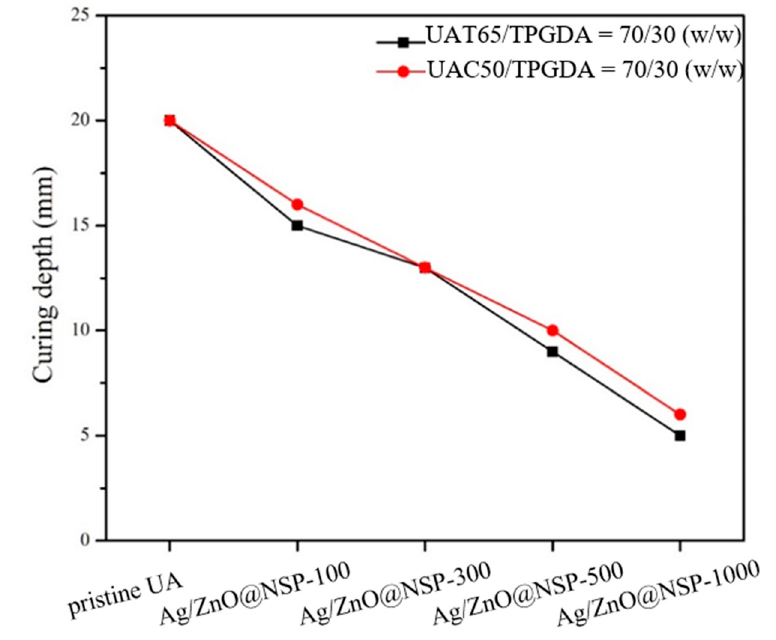
Figure 11. Curing depths of UAT65/TPGDA resins ( w/w = 70/30) and UAC50/TPGDA resins ( w/w = 70/30) with various Ag/ZnO@NSP contents (ppm).